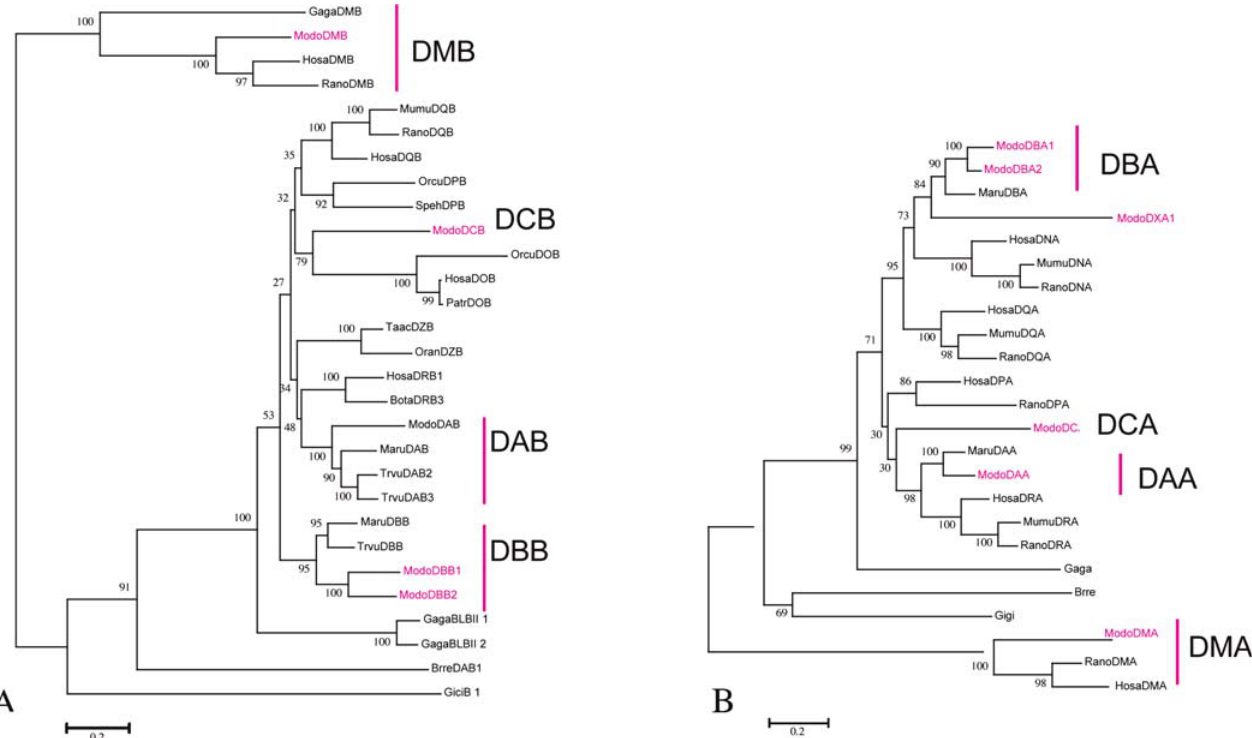
Figure 5. Phylogenetic Tree of the MHC Class II Genes (A) MHC Class IIB gene phylogeny based on full length amino acid sequences. Prior studies have named DAB and DBB [17]. Here we report a new Class IIB gene family, DCB . The DMB genes were used as the outgroup. DAB was not found in scaffold_42 and a cDNA sequence was used for the analysis. Physical mapping localizes DAB BACs to the centromeric region of 2q, and it appears this gene was not sequenced or was unable to be assembled. (B) MHC Class II A gene phylogeny. Location of IIA genes near IIB genes in scaffold_42 allowed designation of IIA genes to class IIB gene families: DA, DB, and DC. Bootstrap values are too low to be able to ascertain orthology with eutherian gene families. DOI: 10.1371/journal.pbio.0040046.g005